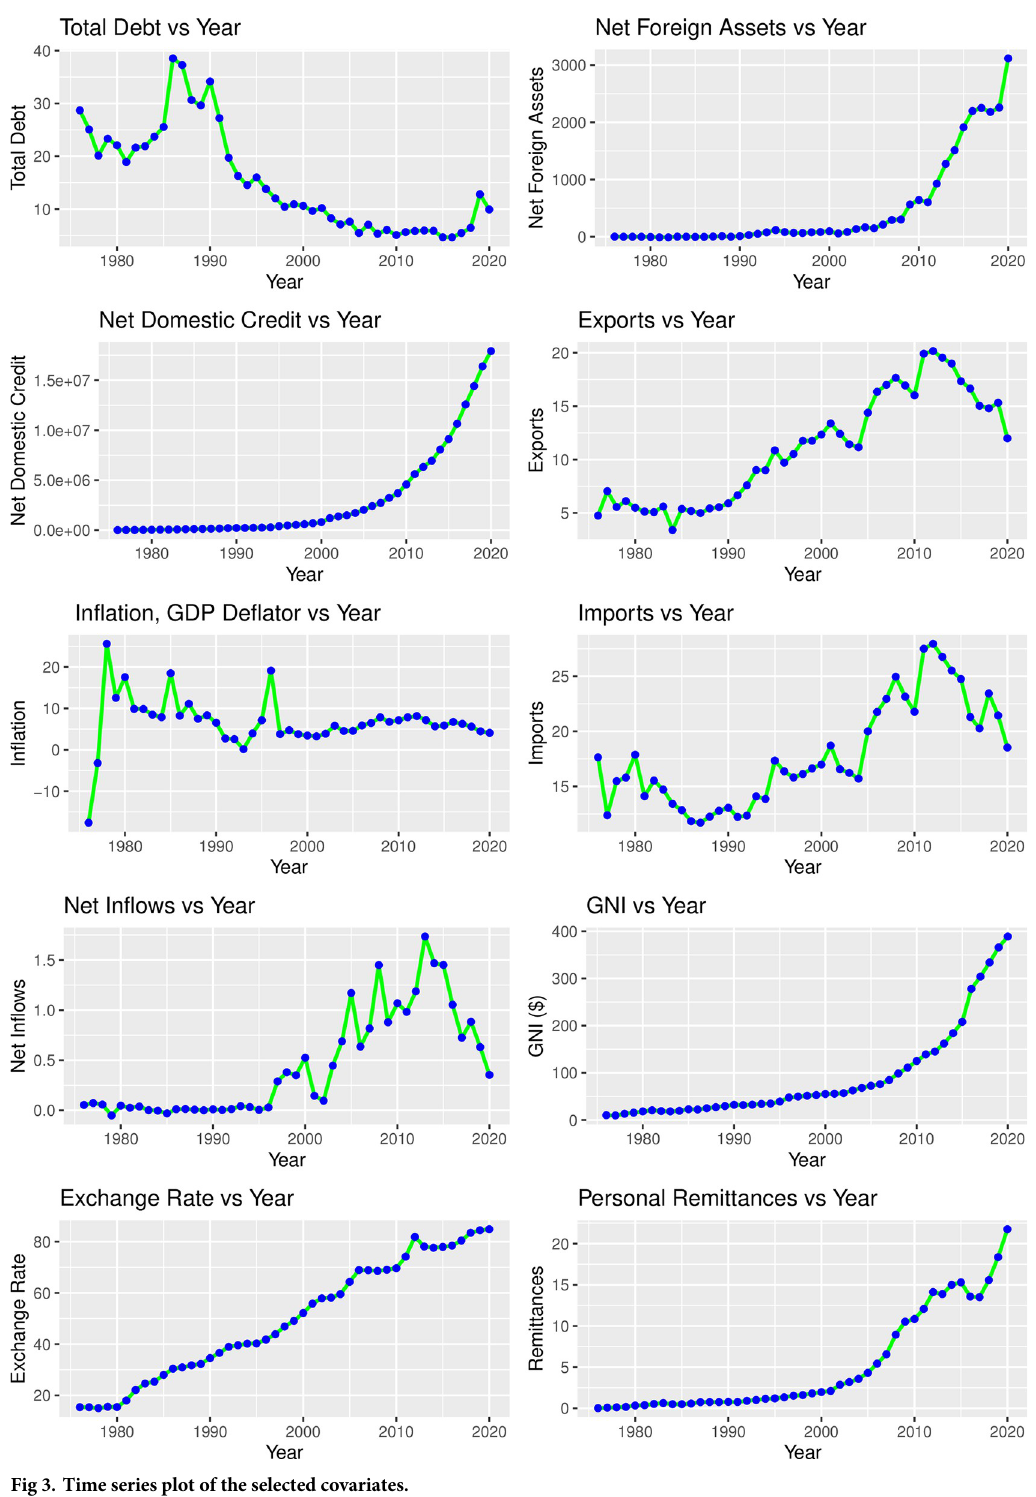
Fig 3. Time series plot of the selected